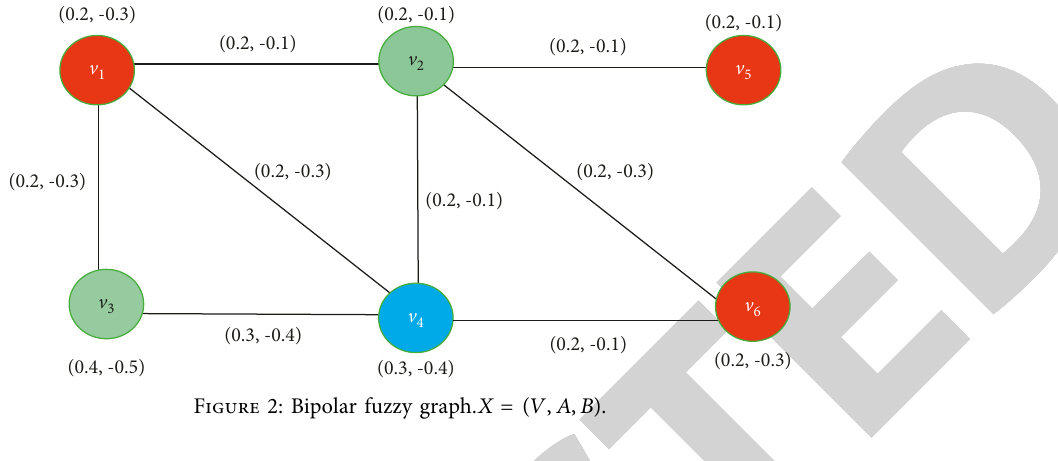
Figure 2: Bipolar fuzzy graph. X